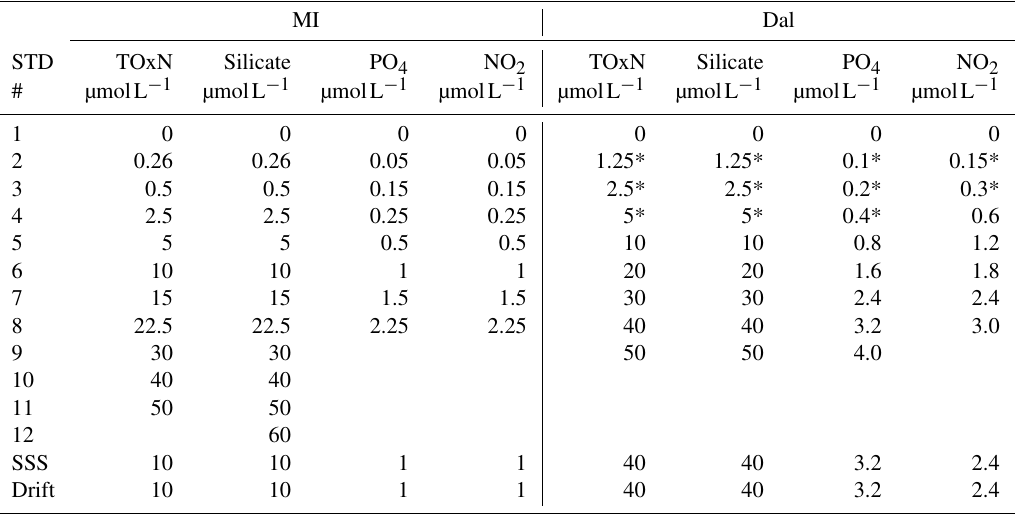
Table 2. Concentrations of daily calibration standards in µmolL − 1 on the MI and Dal systems. Standard 1 is the blank made of artificial seawater (sal 35). Following discussions with the MI group after the first seven runs, standards 2–4 (indicated with a *) on the Dal system were added to the Dal systems’s standard curve for the last 5 days of analysis. SSS are the system suitability standards that were analysed during a run as internal quality